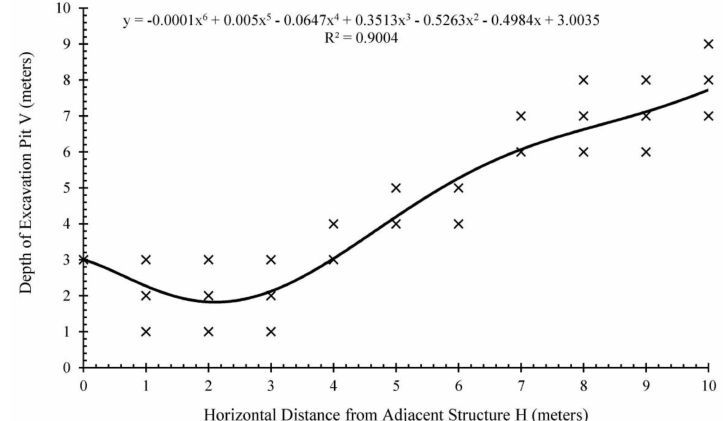
Fig. 9. Plot of all scenarios for values of H and V at